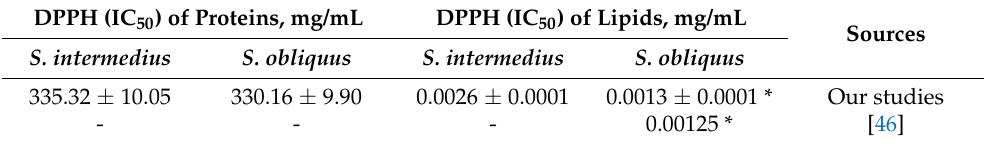
Table 6. Values of antioxidant activity of S. typhimurium and S. obliquus microalgae samples obtained in various